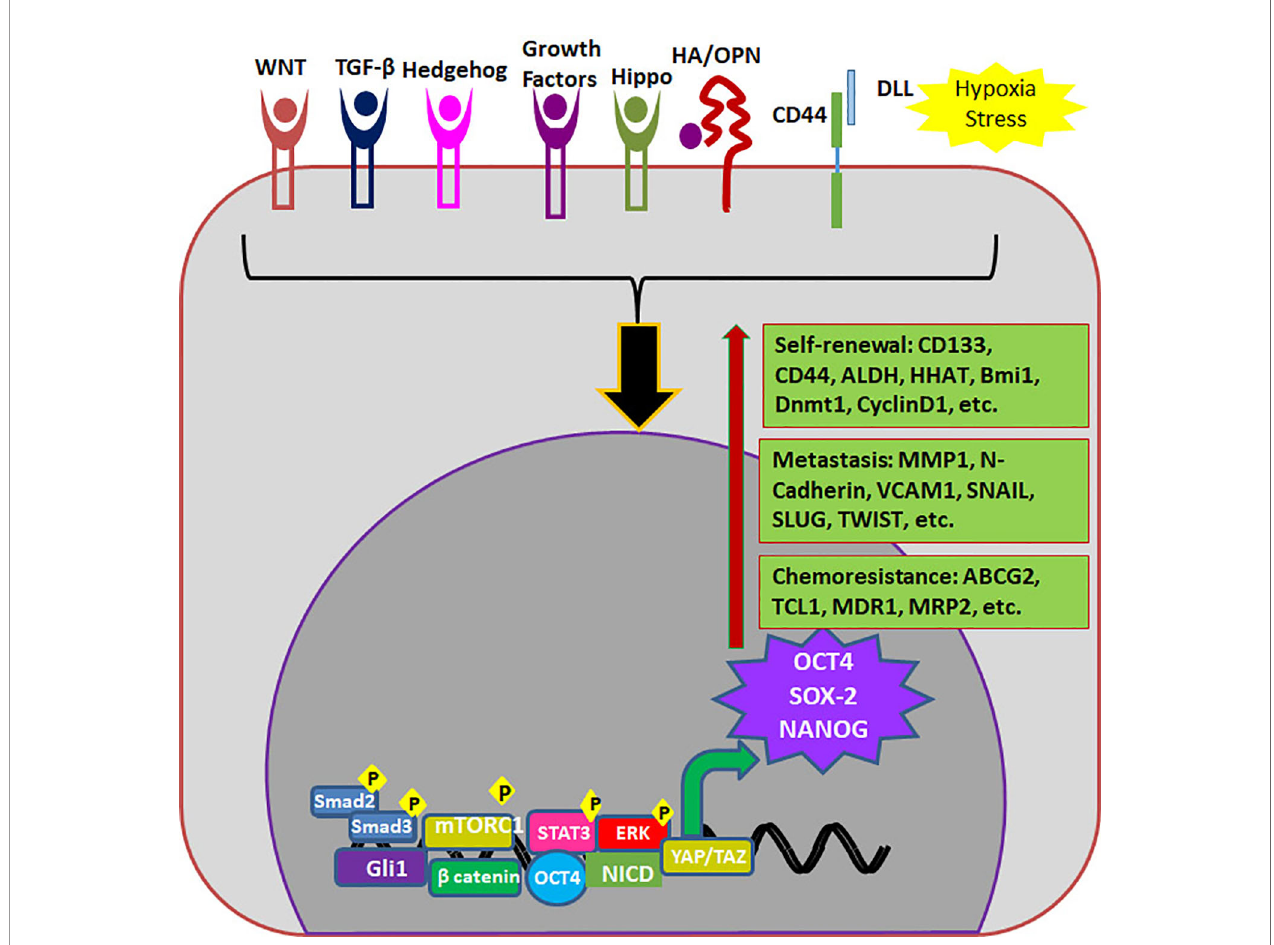
FIGURE 4 | Endogenous markers regulating properties of CSCs. Different signaling pathways regulate the expression of OCT4, SOX2 and NANOG which in turn up-regulates different molecules required for self-renewal, metastasis and